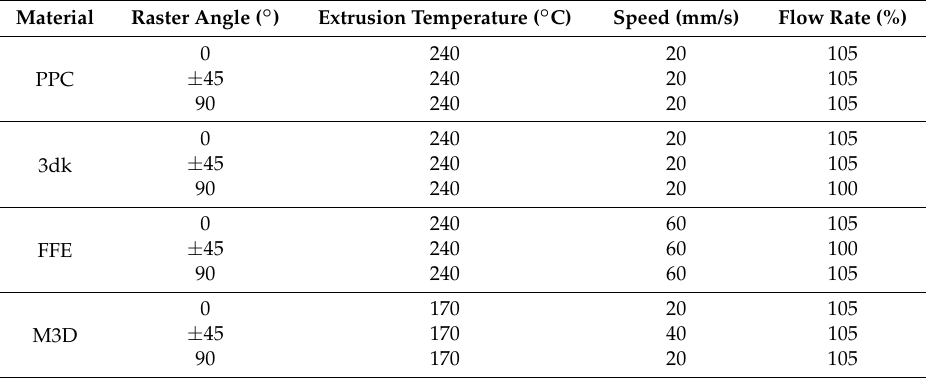
Table 5. Utilized process parameter sets of the specimens represented in Error! Reference source not found. .